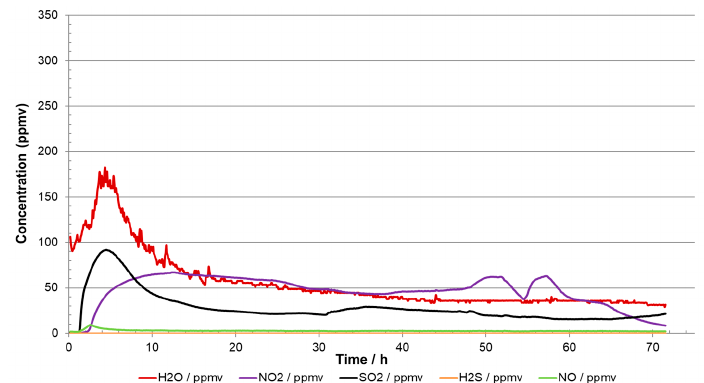
Figure 10. The result of simultaneous injection of 300 ppmv H 2 O, 350 ppmv O 2 , 100 ppmv of NO 2 , SO 2 , and H 2 S in 100 bar CO 2 and 25 °C. None of the impurities reached their setpoint due to reac- tions [9]. The O 2 content was not measured due to experimental problems.